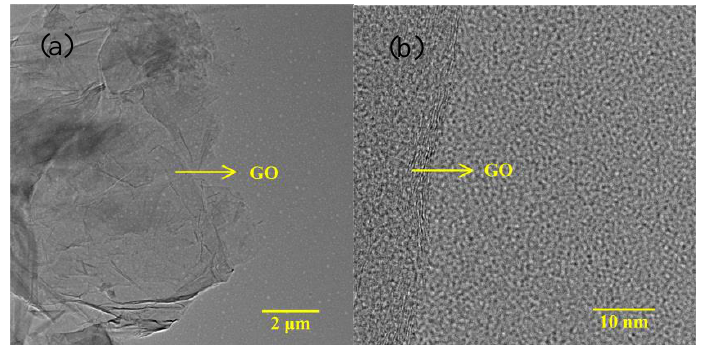
Figure 2. TEM images of GO: ( a ) low resolution and ( b ) high resolution.